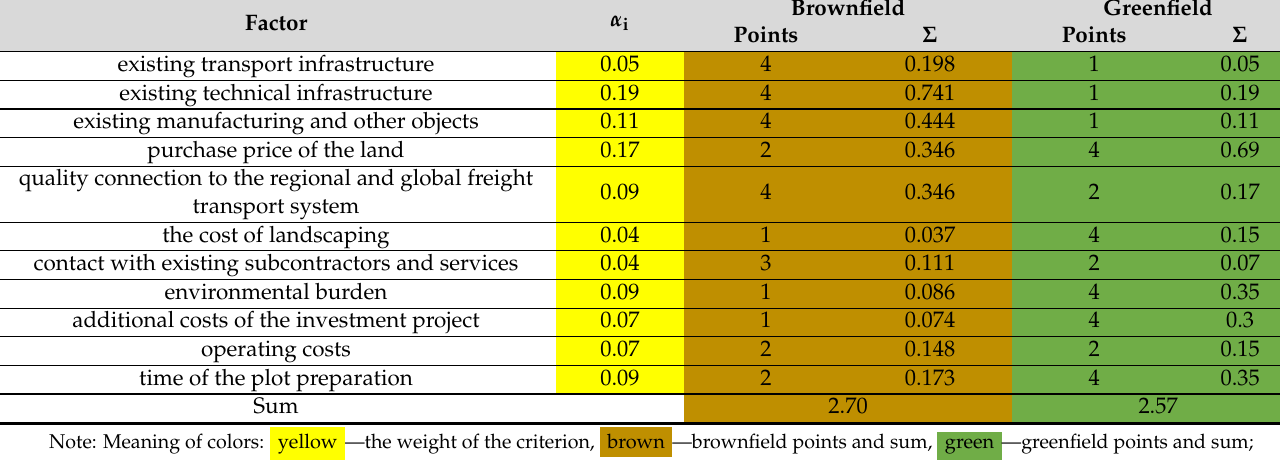
Table 3. A comparison of the investment projects of brownfield and greenfield industrial parks